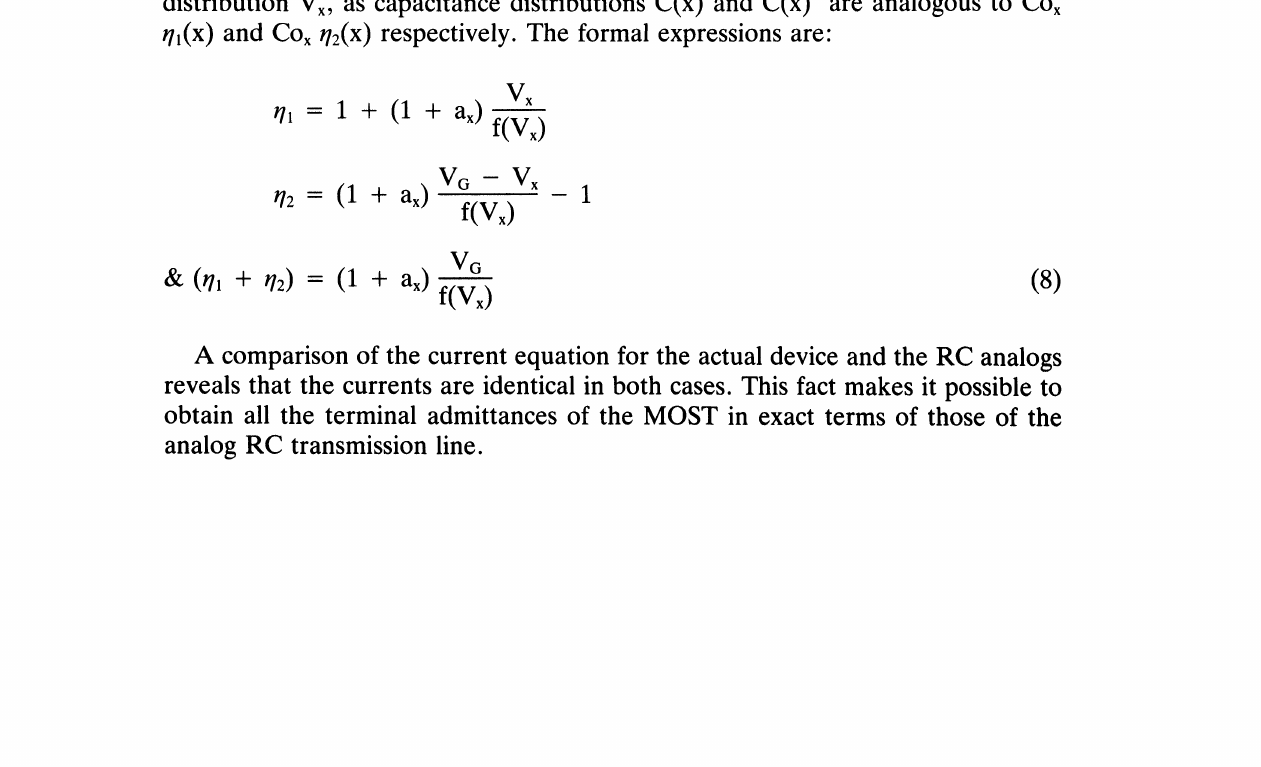
Fig: FIGURE 4a RC double transmission analogs of the MOST under gate excitation. FIGURE 4b Under substrate excitation. FIGURE 4c Under the gate-substrate